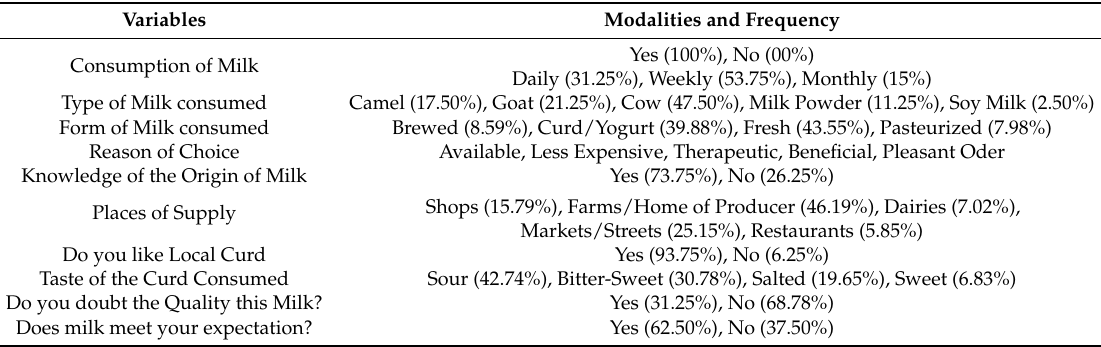
Table 3. Consumption and assessment of the local curd.